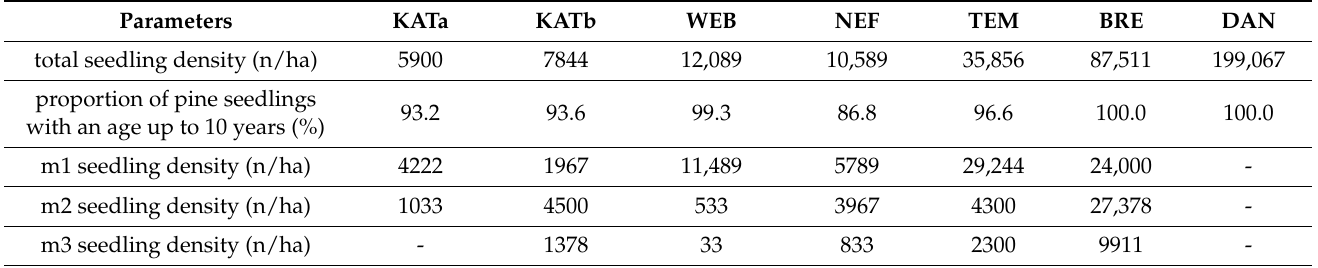
Table 2. Mean values and coefficients of variation (in brackets) of total pine seedling densi- ties, separated by microsite types (m—microsite, m1—stand conditions without soil scarification, m2—skid trail, m3—skid trail border, m4—hollows or furrows, m5—mounds, m6—stand